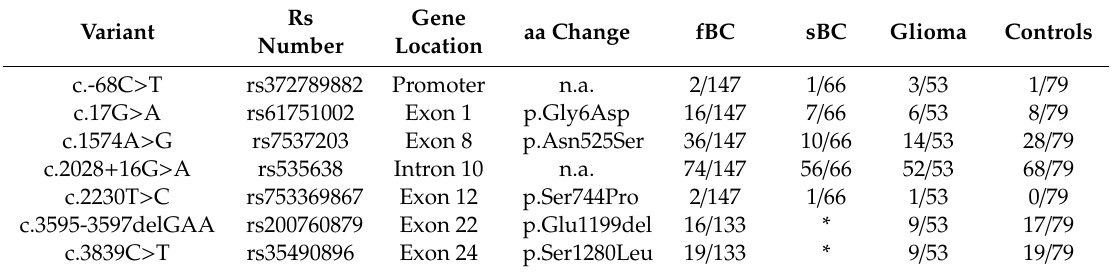
Table 1. Claspin gene ( CLSPN ) variants detected in breast cancer and glioma patients.